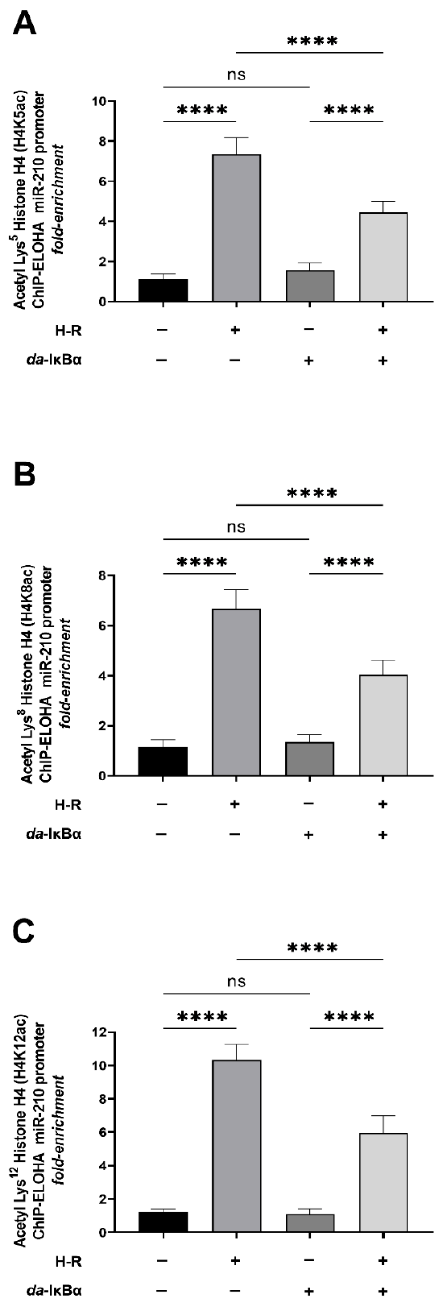
Figure 6. Hypoxia–reoxygenation (H-R) challenge-induced increase in acetylation of characteristic lysine residues in histone H4 that are signatory of an open permissive and transcriptionally active miR-210 promoter is significantly dependent on NF- κ B activation. ( A – C ) Tandem ChIP-ELOHA analysis showing the relative abundance of histone H4 acetylated at ( A ) Lys 5 —H4K5ac; ( B ) Lys 8 —H4K8ac; and ( C ) Lys 12 —H4K12ac in the miR-210 proximal promoter in response to H-R challenge-subjected cells ectopically expressing the da -I κ B α mutant. Data from the ChIP-ELOHA analysis are expressed as fold enrichment by first correcting the respective acetylated histone H4-associated miR-210 promoter fragment ELOHA absorbance values to the respective inputs , followed by normalization to fold change values. Data from the ChIP-ELOHA analysis are depicted as mean fold enrichment ± S.D. from three technical replicates for each of the four biological replicates belonging to each experimental group ( n = 4). **** p ≤ 0.0001; ns: not significant ( p > 0.05). S.D.: standard